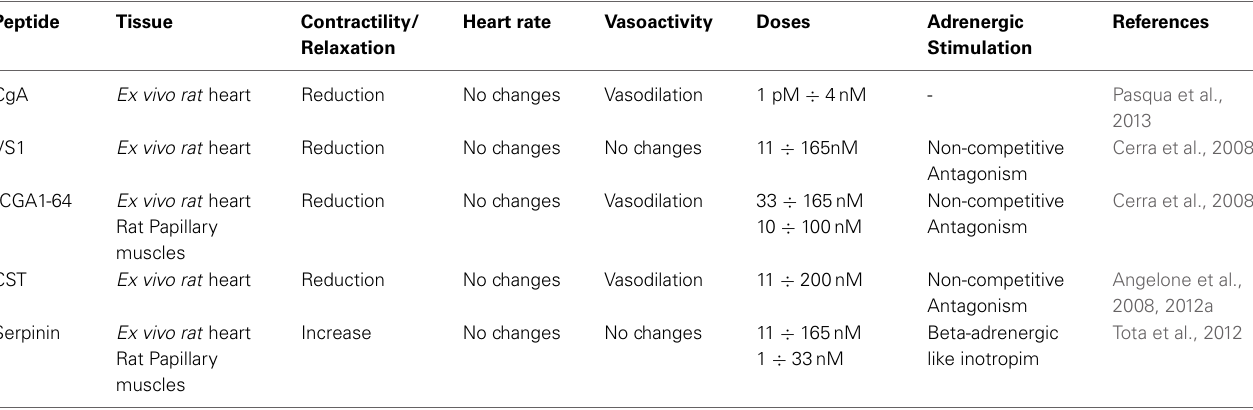
Table 1 | Synopsis of the cardiac effects of CgA and its derived peptides.